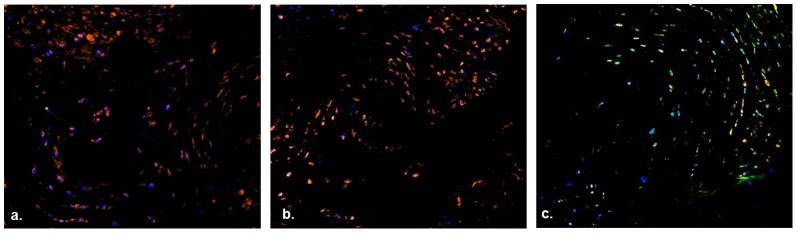
Demonstration of ex vivo murine IVD genetic recombination.
mT/mG mice IVDs were cultured for 10 days in the presence of (a) standard culture conditions, (b) control adenovirus, or (c) cre-recombinase expressing adenovirus. Images are 20× magnification Slides are counterstained with DAPI (blue). Red fluorescence represents no genetic recombination, green fluorescence represents successful genetic recombination, and yellow fluorescence represents an ongoing genetic recombination event.